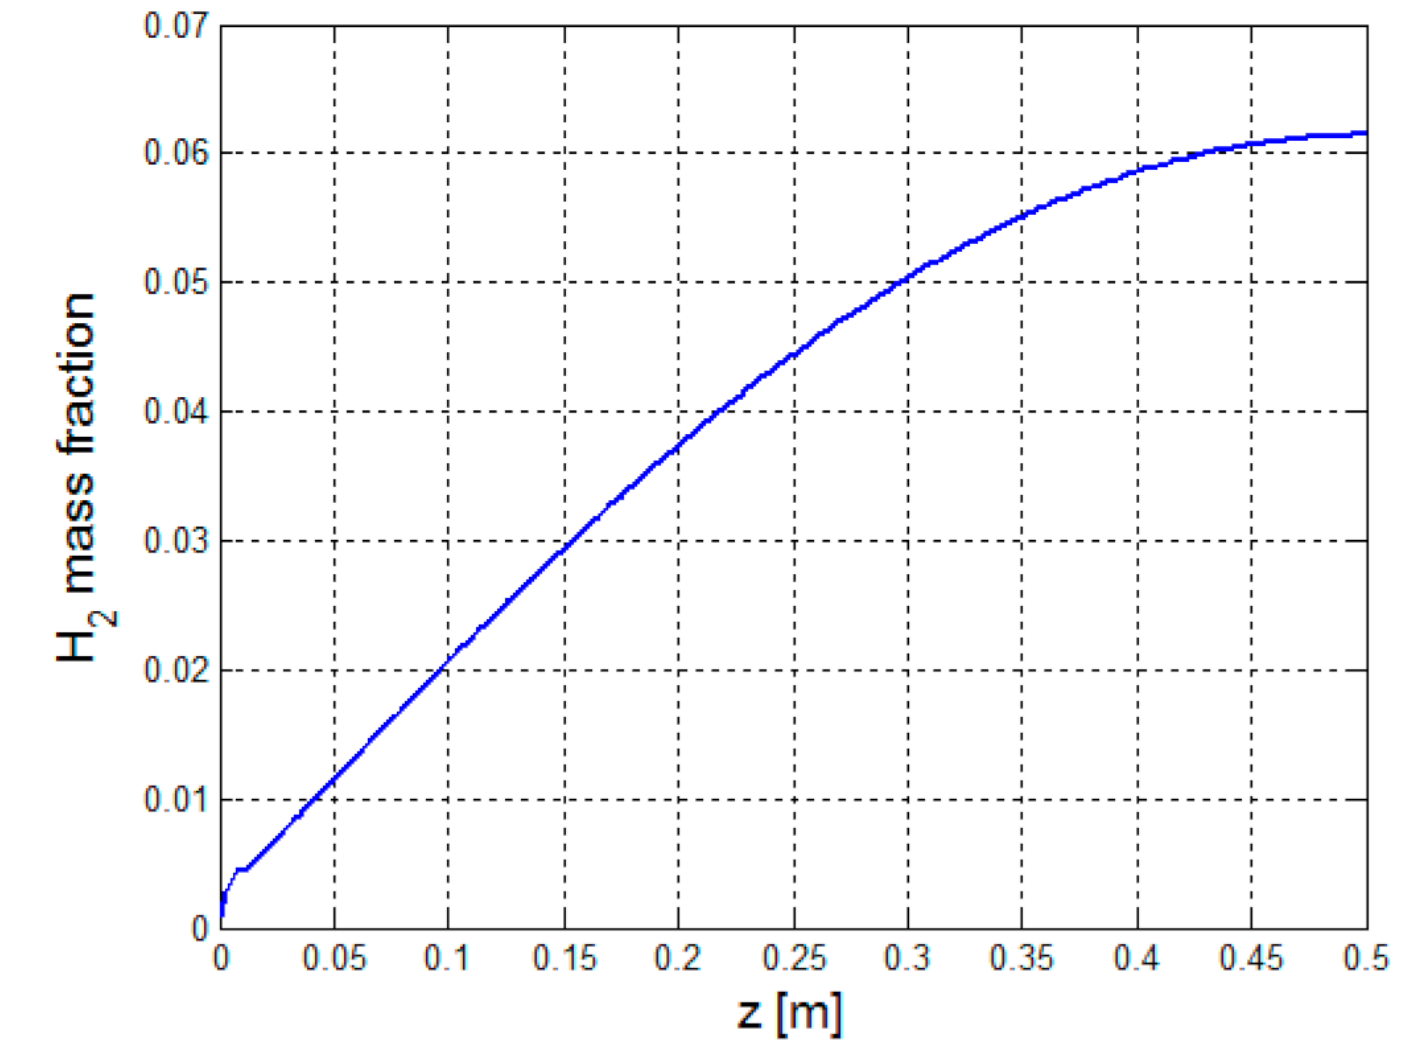
Figure 21. Hydrogen mass fraction along the MSR